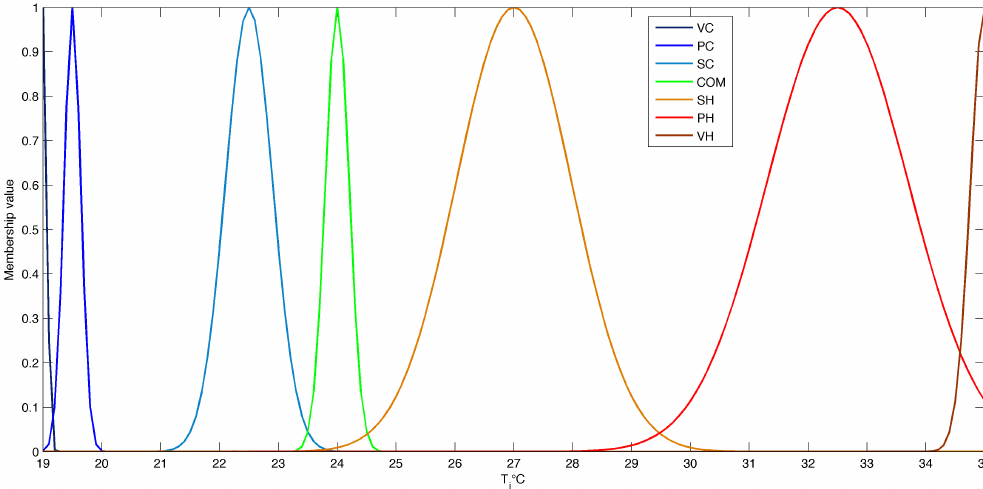
in the summer i